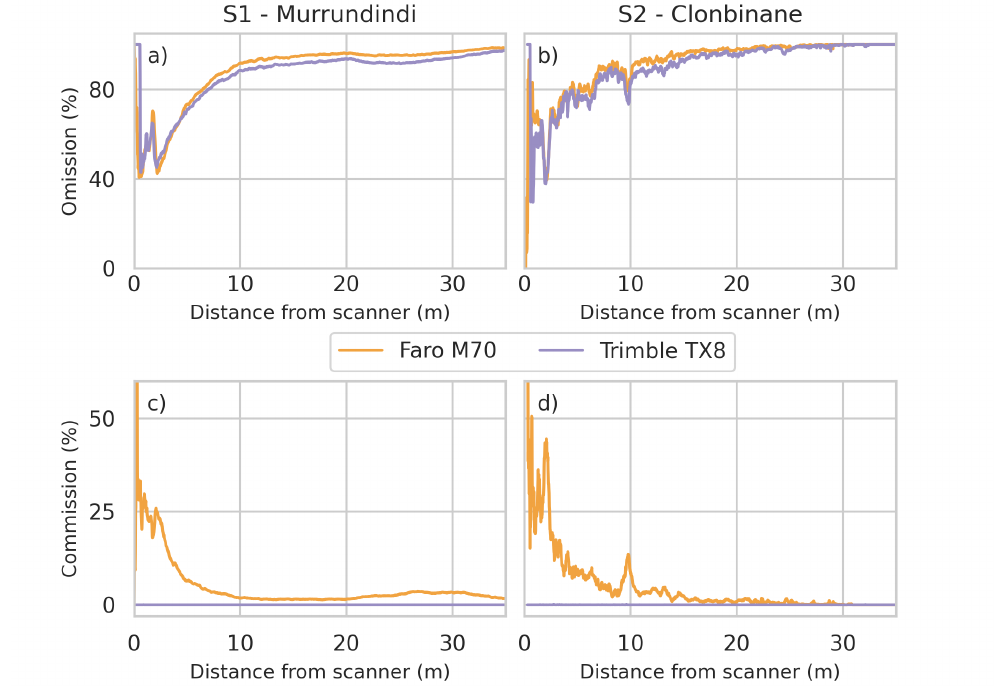
Figure 4. Effect of distance from scanner on the rates of omission ( a ) S1 and ( b ) S2, and commission ( c ) S1 and ( d ) S2, of the observed space for single scans when compared to the reference voxel space created using the merged